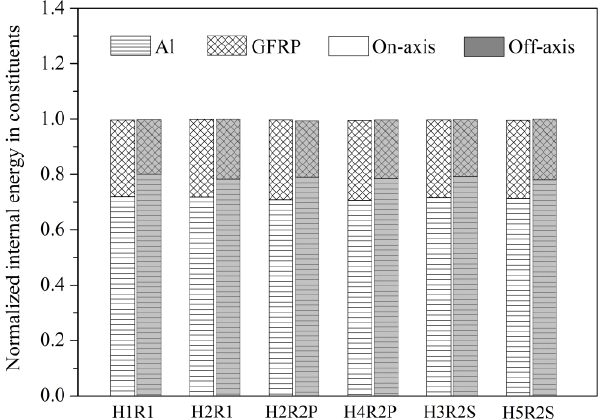
Figure 12. Normalized internal energy in constituents of Glare with different hole arrangements.